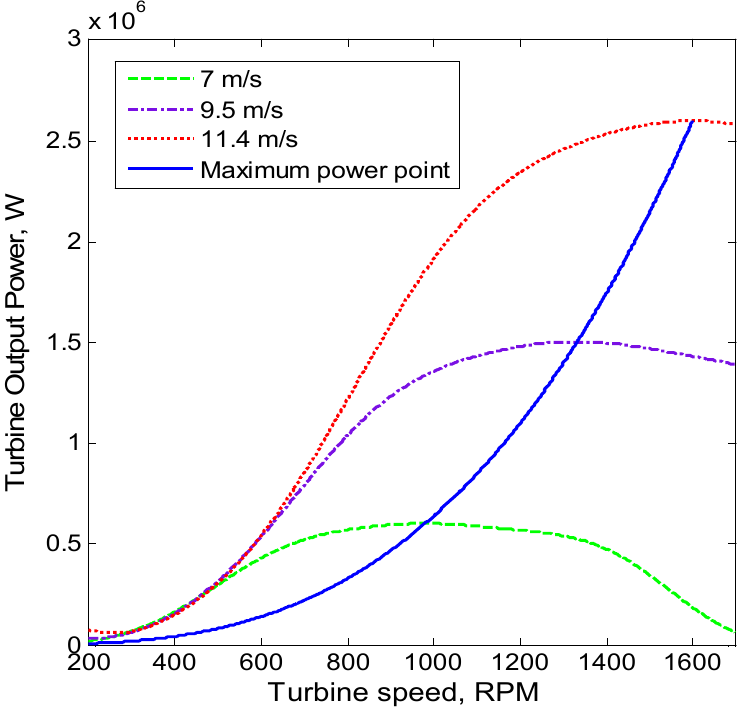
Figure 6. MPPT control under the variation in wind